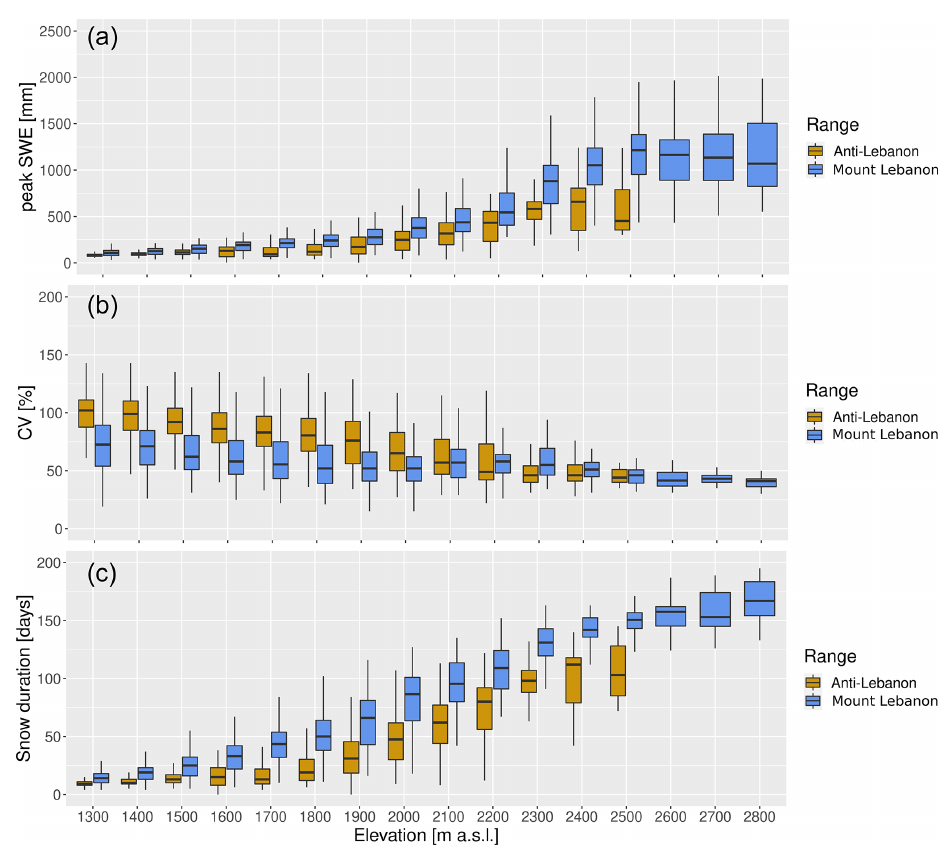
Figure 9. Relationship between annual peak SWE and elevation (a) , coefficient of variation and elevation (b) and snow duration and elevation (c)